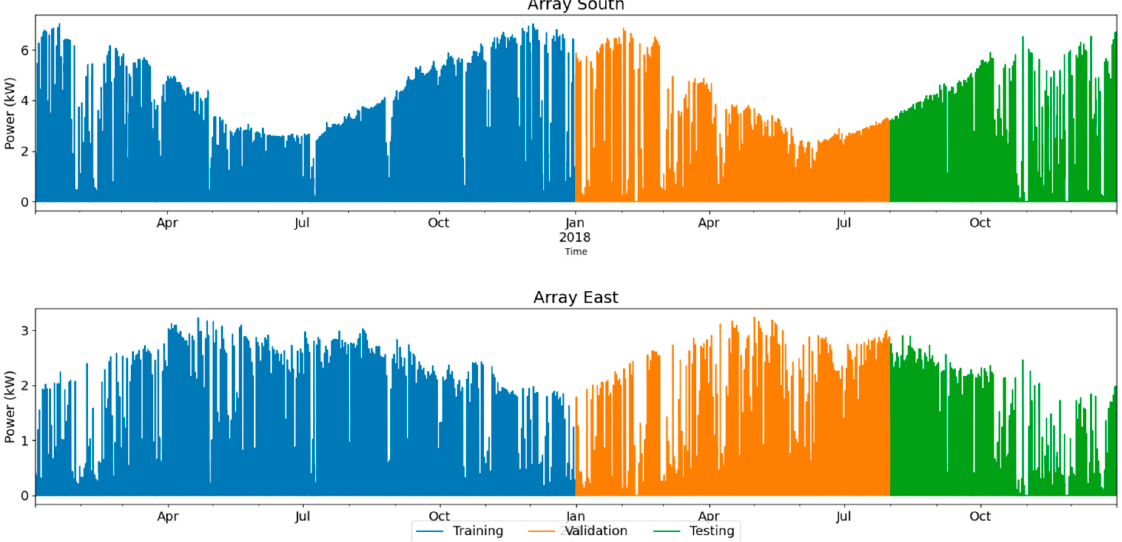
Figure 2. BIPV power datasets for south and east arrays.